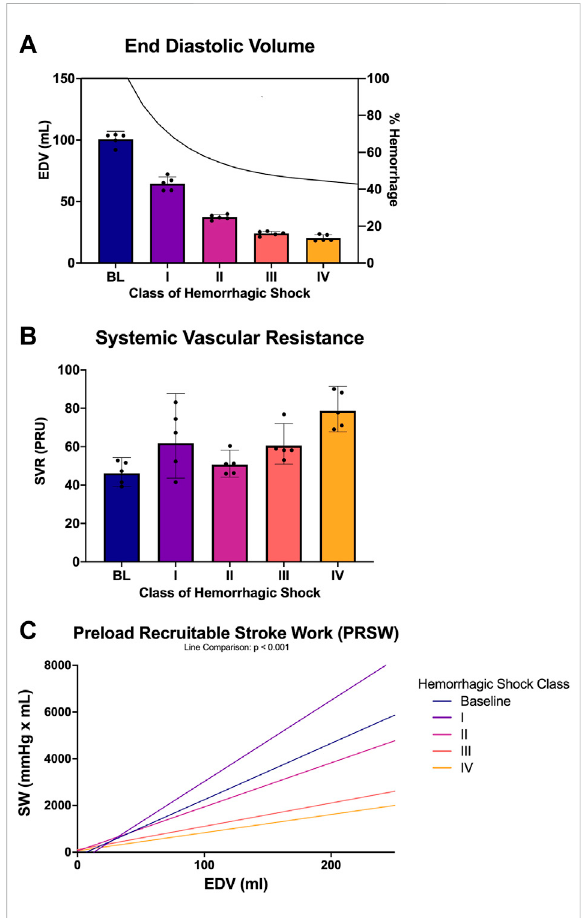
FIGURE 4 PV loop analysis across baseline and each class of hemorrhagic shock (A) end-diastolic volume (EDV) and estimated percent blood hemorrhaged from the logarithmic bleed at each study period, (B) systemic vascular resistance (SVR) from baselineandeachclassofshock,and (C) preloadrecruitablestroke work (PRSW) from baseline and each class of hemorrhagic